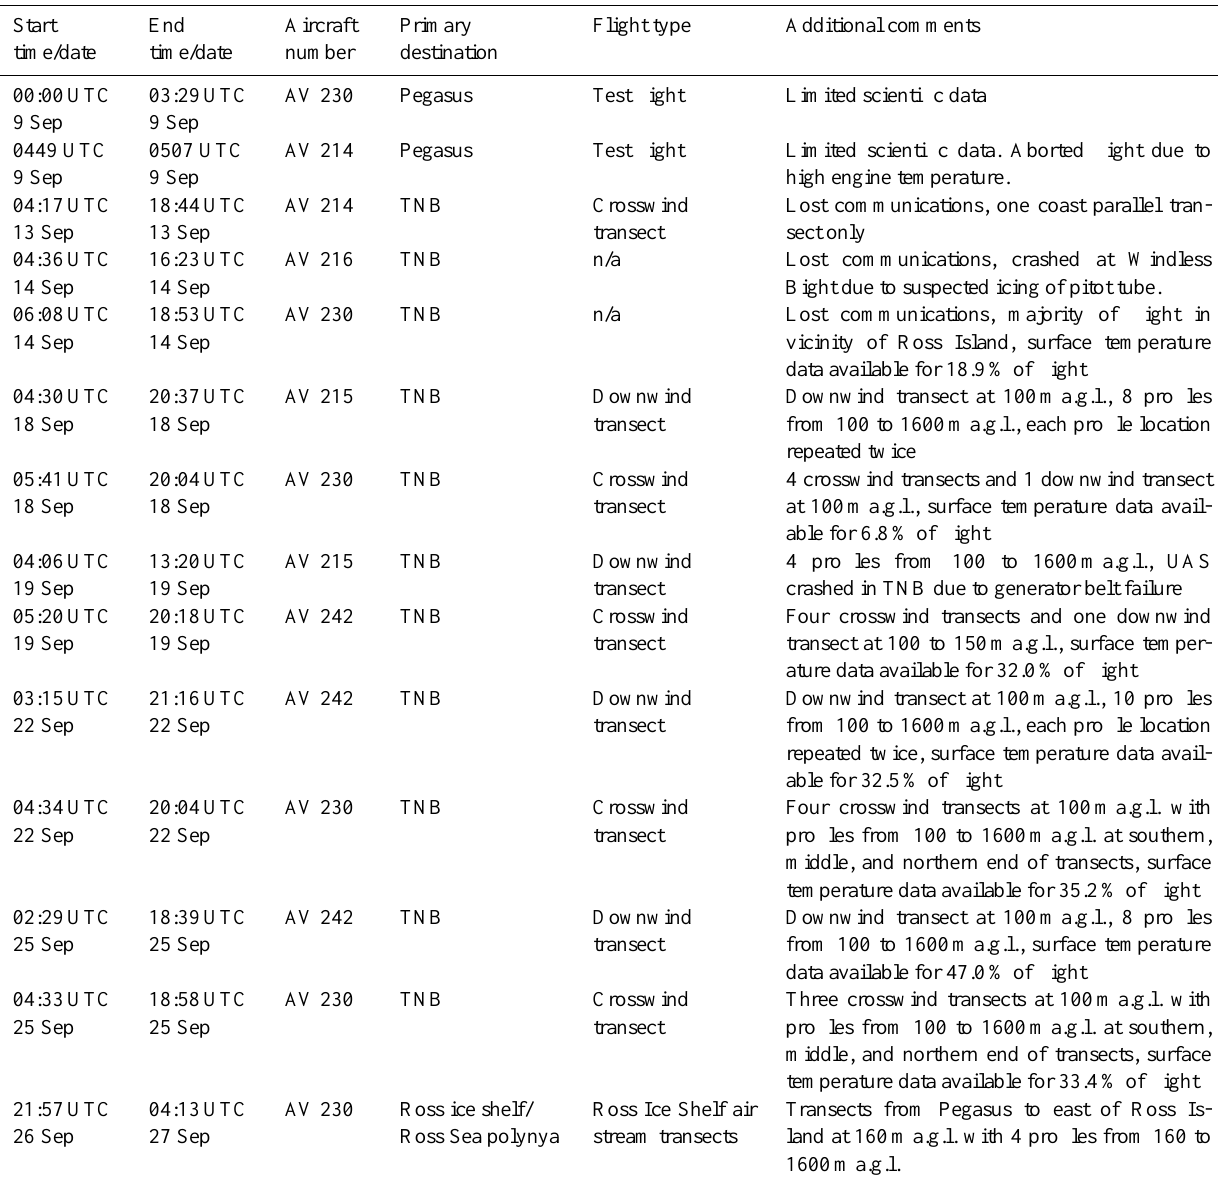
Table 3. Summary of Aerosonde UAS flights during September 2012 including start and end time and date of each flight, aircraft number, primary flight destination, flight type (see text for additional details), and additional comments describing flight transect heights and number and altitude range of profiles.